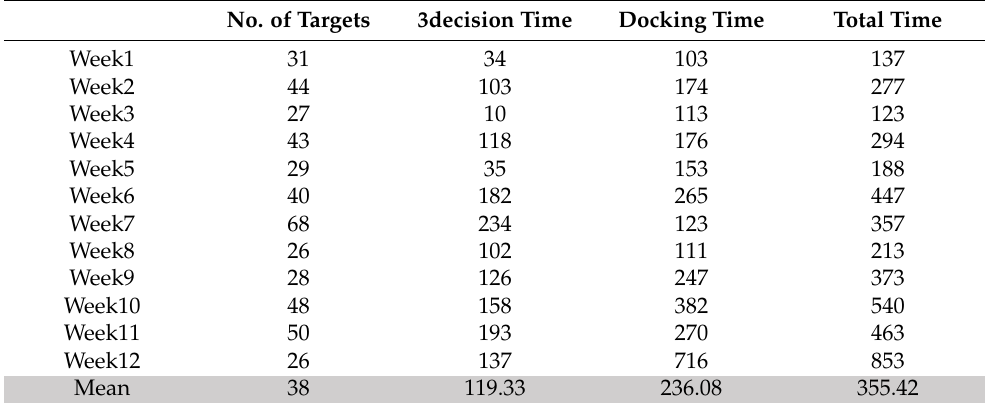
Figure 4. Relation between RMSD and the MCSS score using ( A ) the test set and ( B ) the validation set. Free docking results shown in red, docking with pharmacophoric restraints in green (version 1) and yellow (version 2; only applied to the validation set) and MCS-tethered docking in blue. Table 2. Statistics of the pipeline implementation CELPP